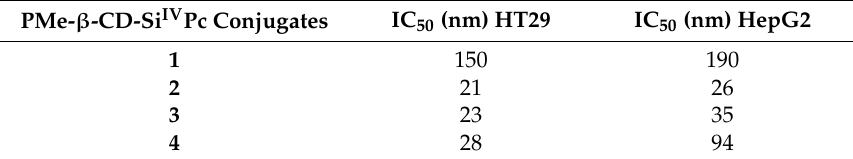
Table 5. IC 50 value comparison of PMe- β -CD-Si IV Pc conjugates 1 – 4 against HT29 and HepG2 cells.